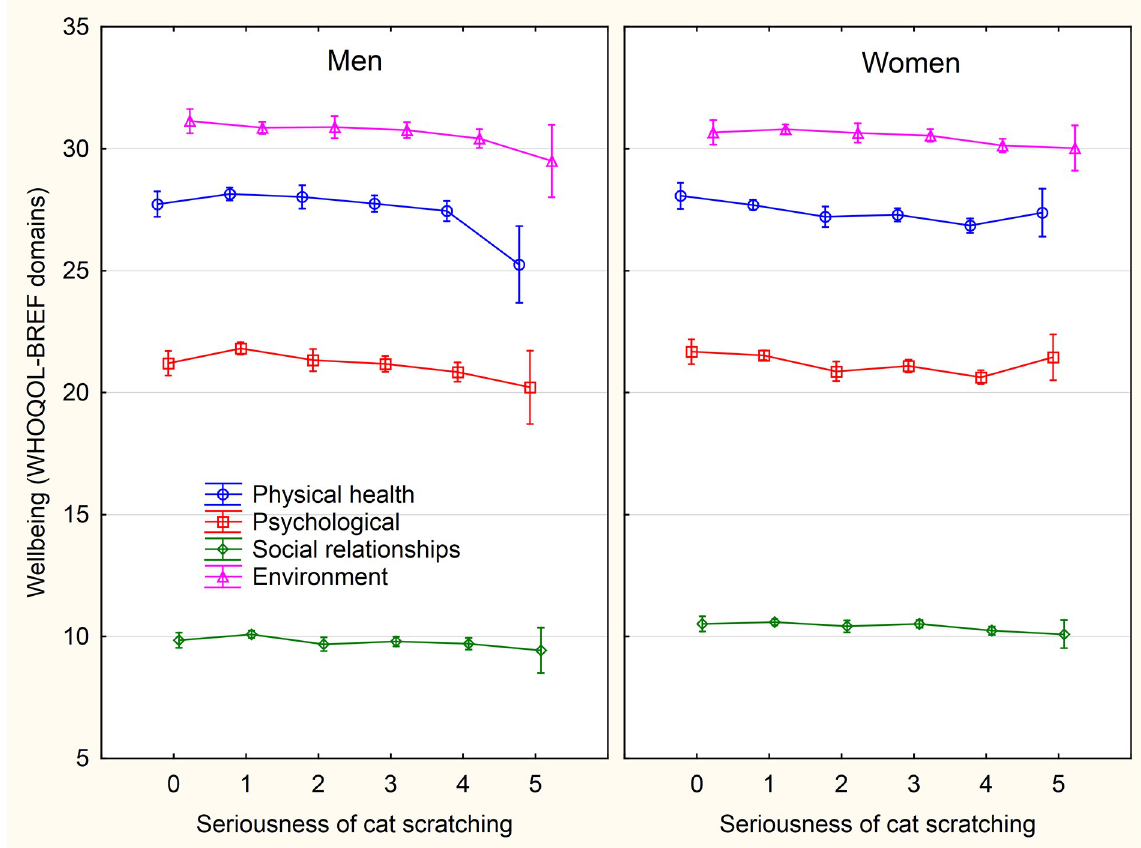
Fig 4. Association between intensity of sustained cat scratching and wellbeing—The scores of WHOQOL-BREF domains. The categories on x-axis describing the intensity of being injured by a pet are: 0- never, 1- only while playing, 2- only as a warning, 3- yes, minor injury (only skin cut), 4- yes, moderate injury (bleeding), 5- yes, serious injury, I had to seek medical